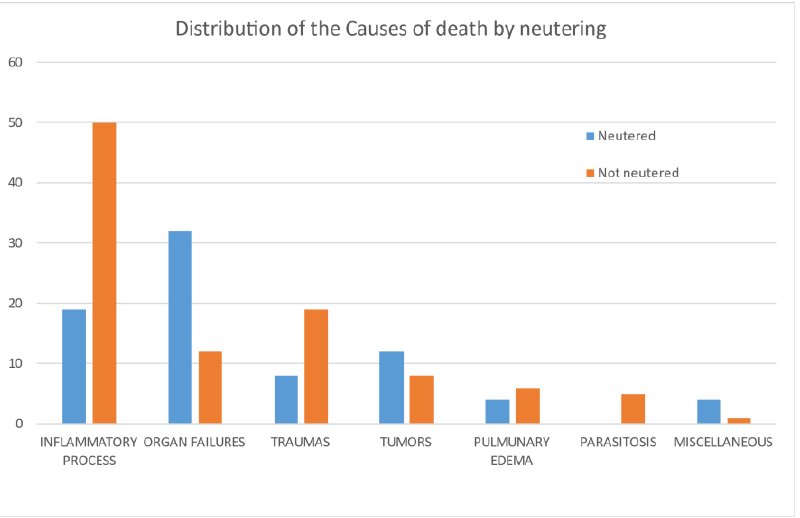
Figure 6. Relation between cause of death and neutering of colony cats included in the study .